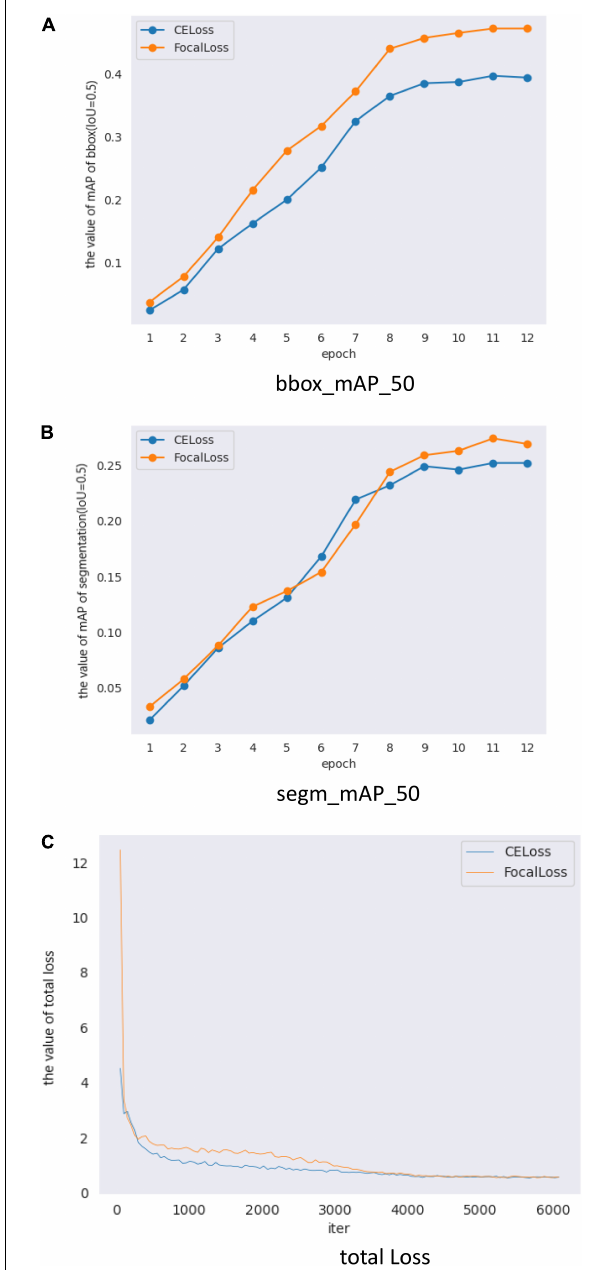
FIGURE 7 | Mask Scoring R-CNN with different loss validation parameters and loss functions. (A) Comparison of mAP_50 of bbox (IoU = 0.5) on different loss, (B) Comparison of mAP_50 of segmentation (IoU = 0.5) on different loss, and (C) Comparison of total loss.